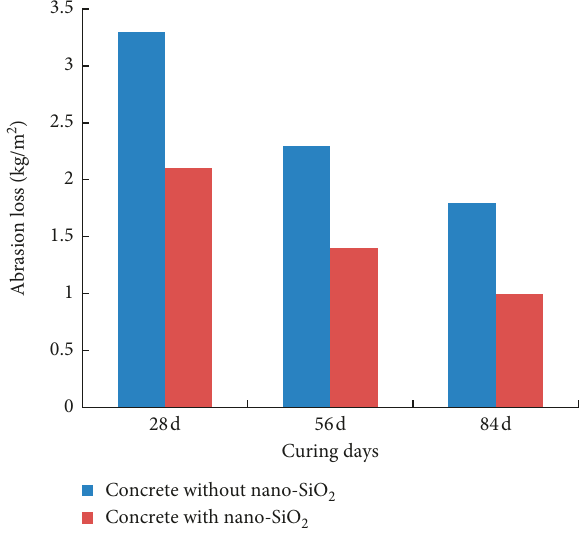
Figure 9: Abrasion resistance test